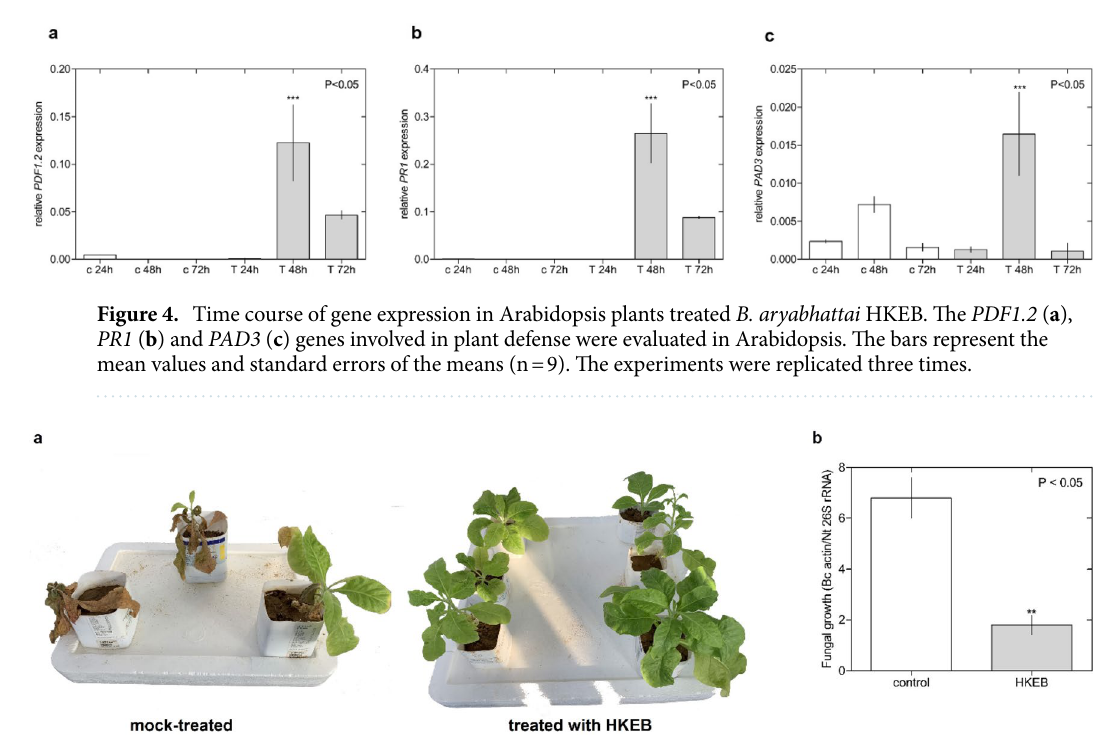
Figure 5. B. aryabhattai HKEB induced an effective defense against B. cinerea infection. ( a ) Disease symptom evaluation in tobacco plants that were mock-treated and treated with HKEB 1 week post-inoculation. ( b ) In planta fungal growth was evaluated using the relative expression of the B. cinerea β-actin gene. The bars represent the mean values and standard errors of the means (n = 10). The experiments were replicated three times.